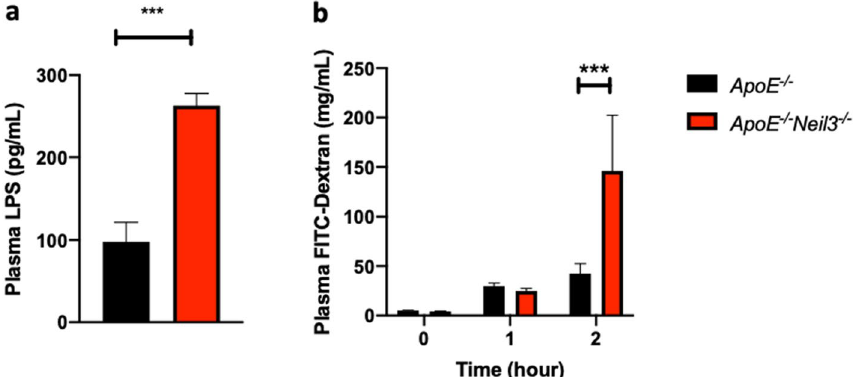
Figure 5. Increased gut permeability in NEIL3-deficient mice. ( a ) Plasma levels of lipopolysaccharide (LPS). ( b ) Plasma levels of FITC-dextran measured in Apoe −/− Neil3 −/− and Apoe −/− mice 1 and 2 h after oral administration. Data are presented as mean ± SEM, Student’s t test, *** p < 0.001, n =